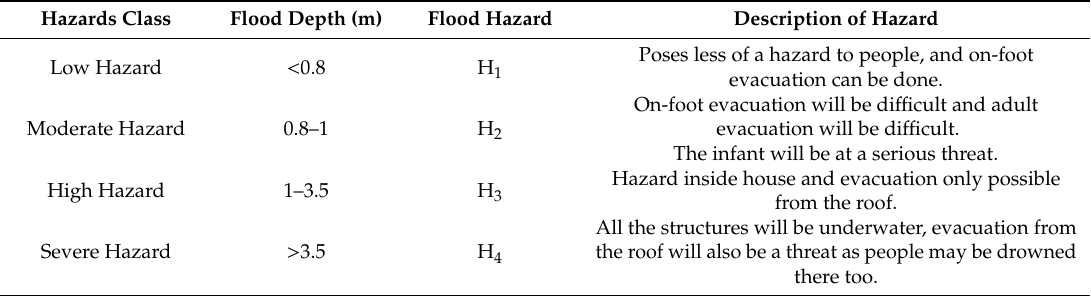
Table 3. Flood hazard classification and its description considering water depth as an indicator of the degree of